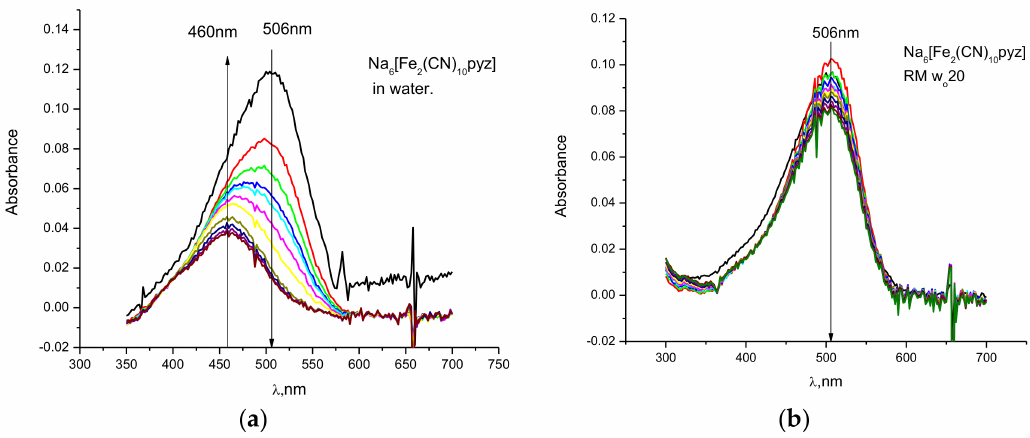
Figure 4. Hydrolysis of the ~5 × 10 − 5 M iron-pyrazine dimer in water ( a ) and a w 0 20 AOT/isooctane RM ( b ). The reaction was monitored for about 2